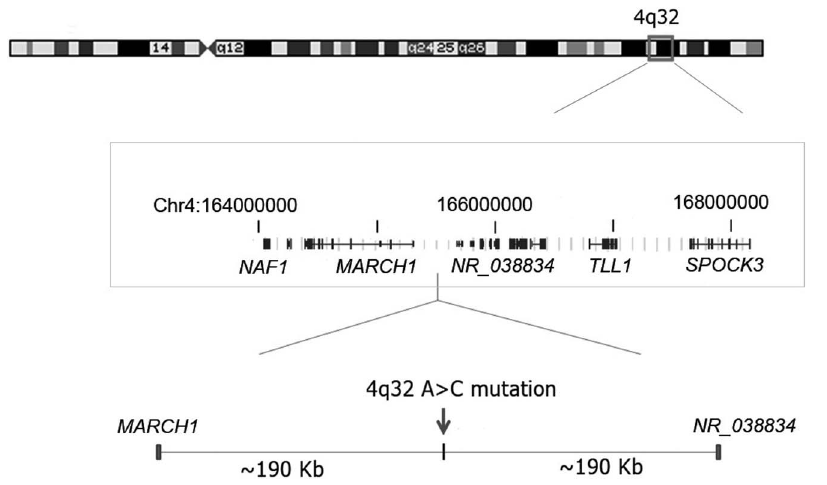
Figure 2. A 4q32A . C mutation in an intergenic region in a large family. Diagram of chromosome 4 showing the area of linkage (boxed) targeted for deep sequencing and the location of the 4q32A . C mutation. Chromosome 4 coordinates and schematic of genes were drawn based on information from UCSC Genome Browser GRCh37/hg19 (not all genes are shown).